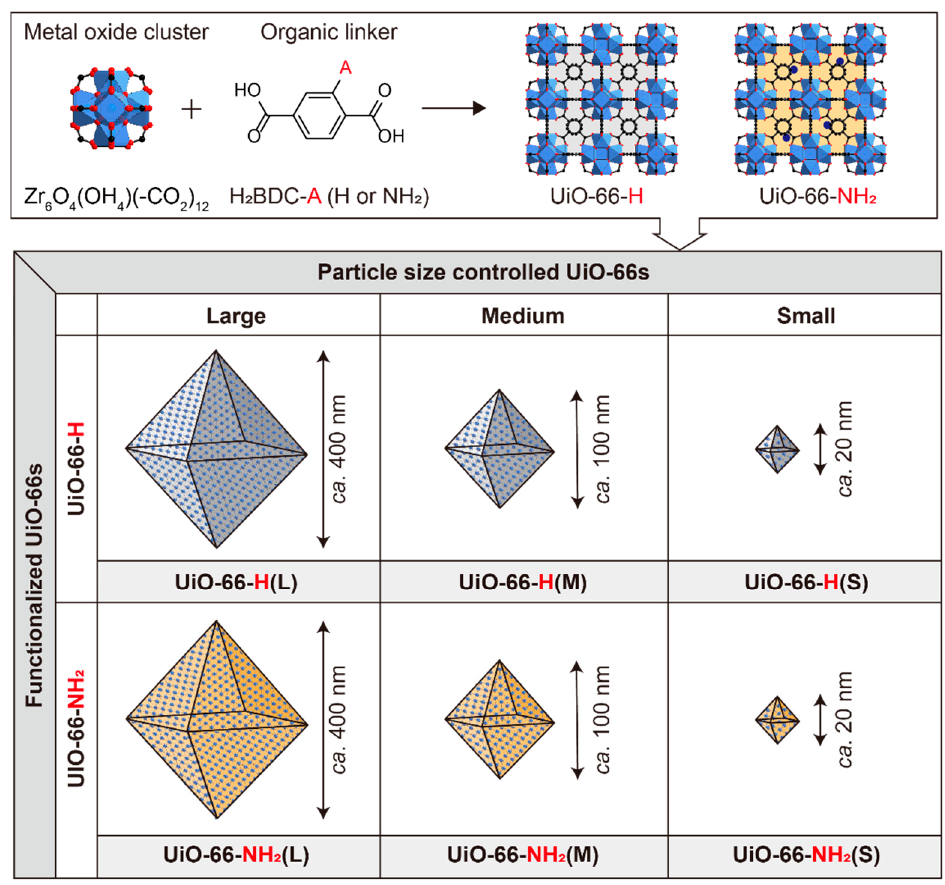
Figure 1. Schematic diagram for the synthesis of UiO-66-H(X) and UiO-66-NH 2 (X) in three different sizes: large (L), medium (M), and small (S).